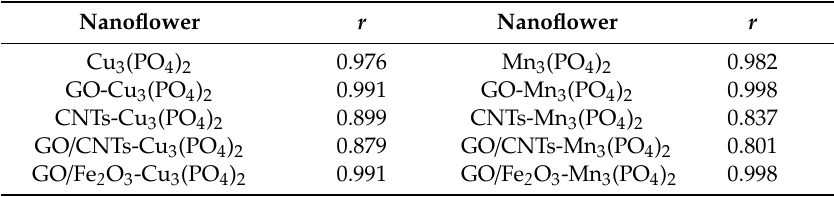
Table 1. Correlation coe ffi cient ( r ) between the FTIR spectra of CaLB-HNFs. Nanoflower r